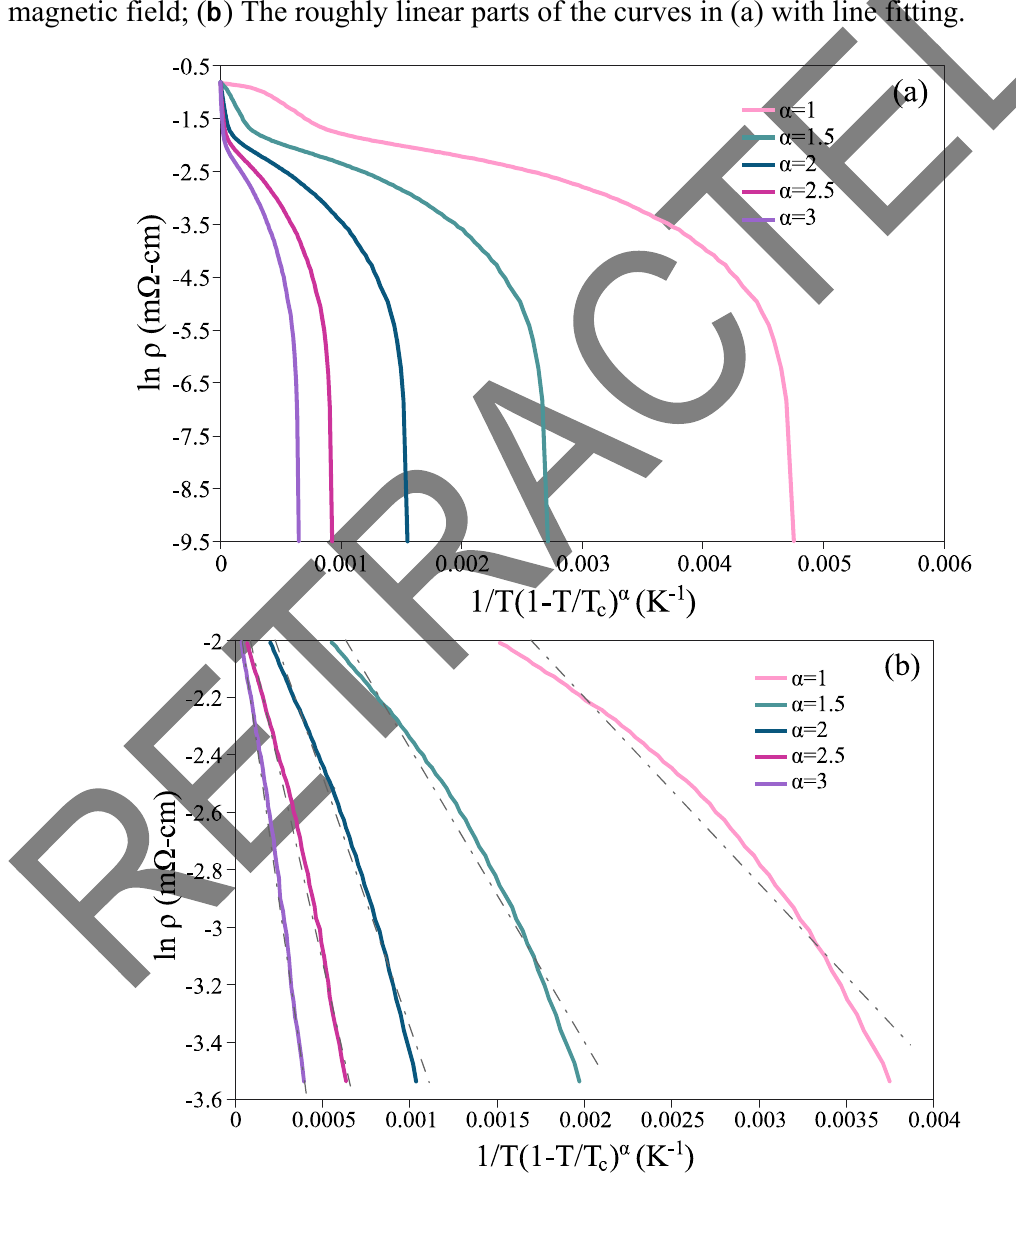
) α for α = 1, 1.5, 2, 2.5, 3 under a 2 c